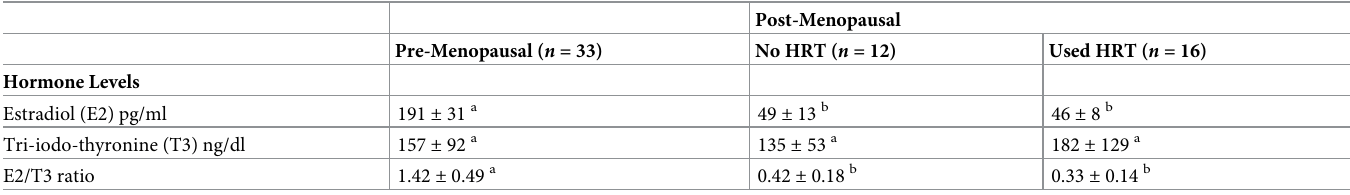
Table 2. Serum estradiol and tri-iodo-thyronine concentrations classified by menopause phase and use of hormone replacement therapy